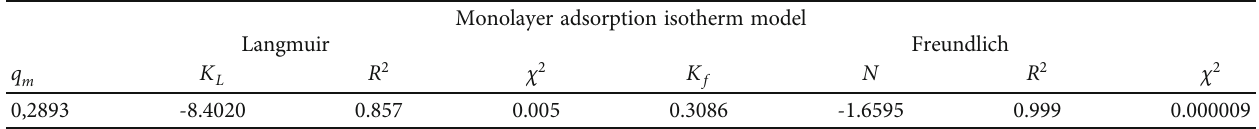
Table 2: Adsorption isotherm model